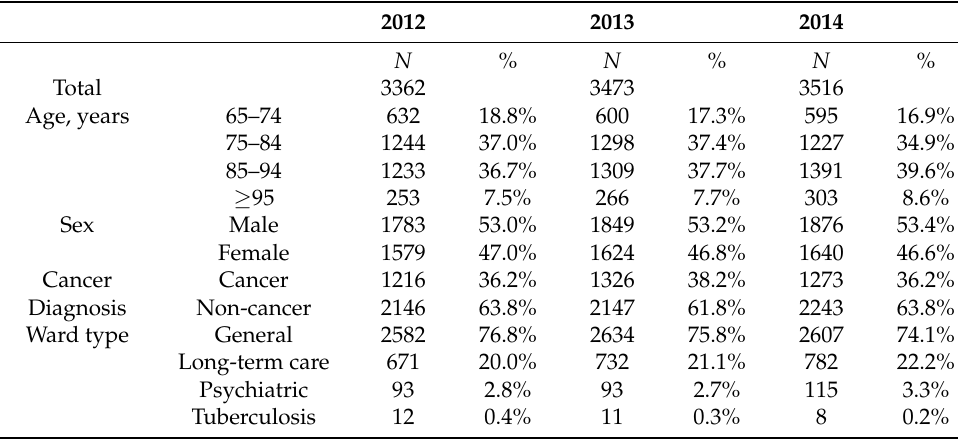
Table 1. Characteristics of deceased patients in October of